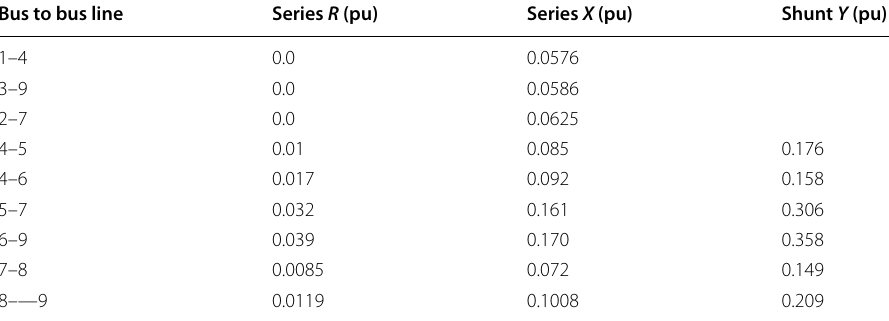
Table 9 IEEE-9 bus line parameters [14]